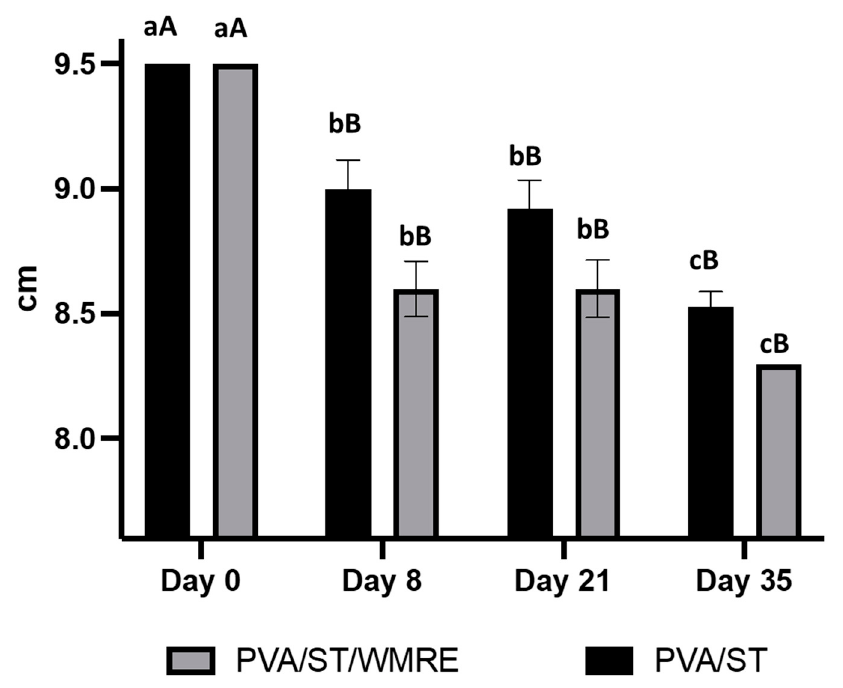
Figure 8. Biodegradation capability based on the length of PVA/ST and PVA/ST/WMRE films when buried in soil at 5 cm depth for 35 days. The different letters represent a significant difference of p < 0.05. The error bar indicates the standard deviation (n = 3). Lowercase denotes significant difference within the day ( p < 0.05 ). Uppercase denotes significant difference within the type of film ( p < 0.05).